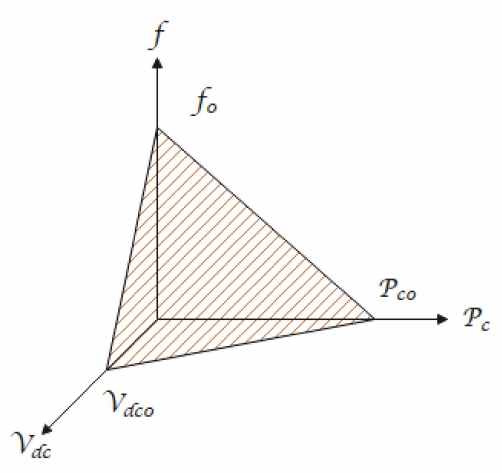
Figure 6. Three-dimensional droop control of ILC (adapted from